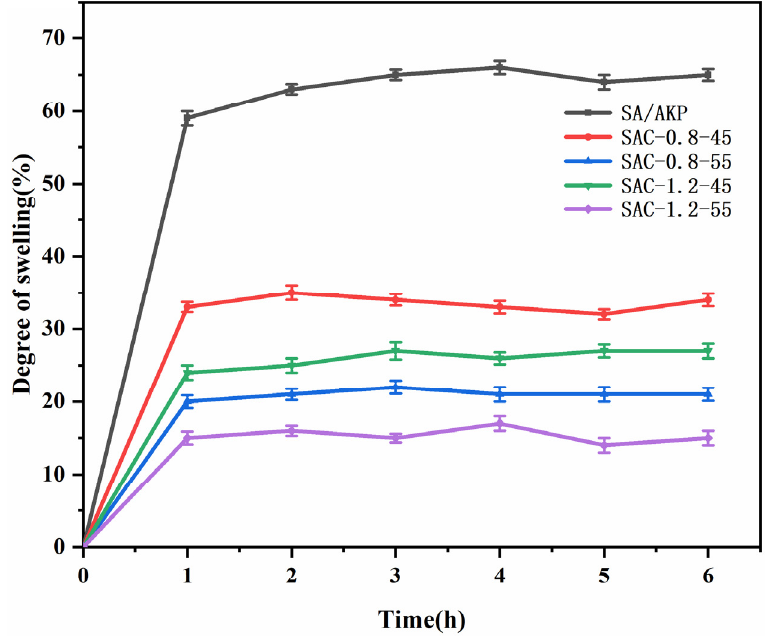
Figure 8. Water absorption of SA/AKP composite fiber and SA/AKP/CNCs composite fiber.